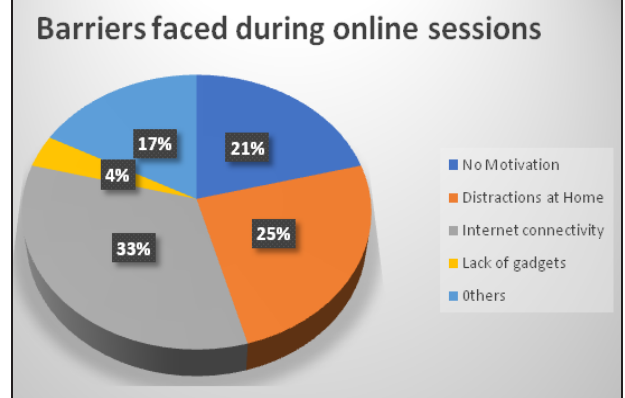
Figure-I:The software used by students/ institutions for e-learning during Lockdown which they were not using before COVID-19 Pandemic.